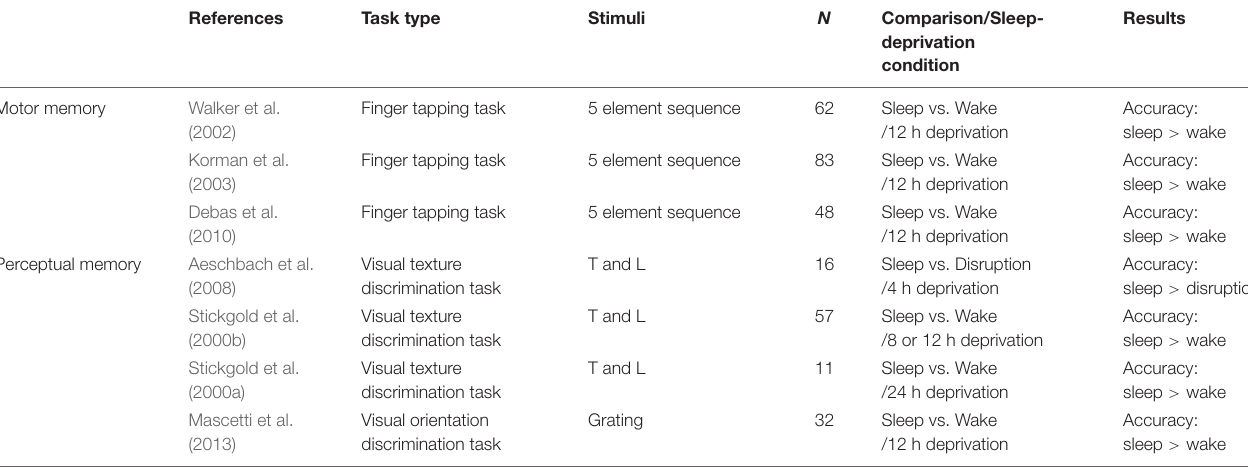
TABLE 2 | Studies of the effects of sleep deprivation on non-declarative